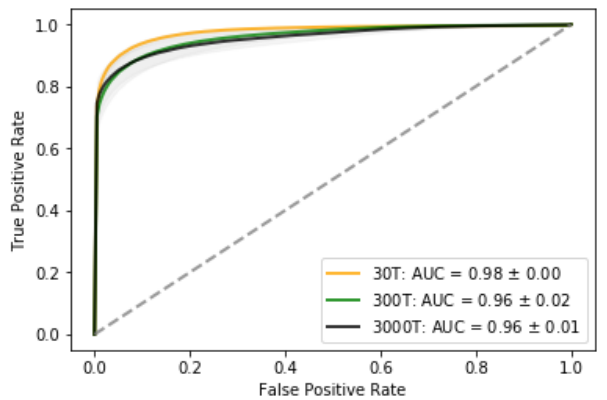
Figure 4. ROC-curves for the three leak scenarios. The 0T scenario is not included since it in all cases will be classified as no-leak, i.e., there are no false